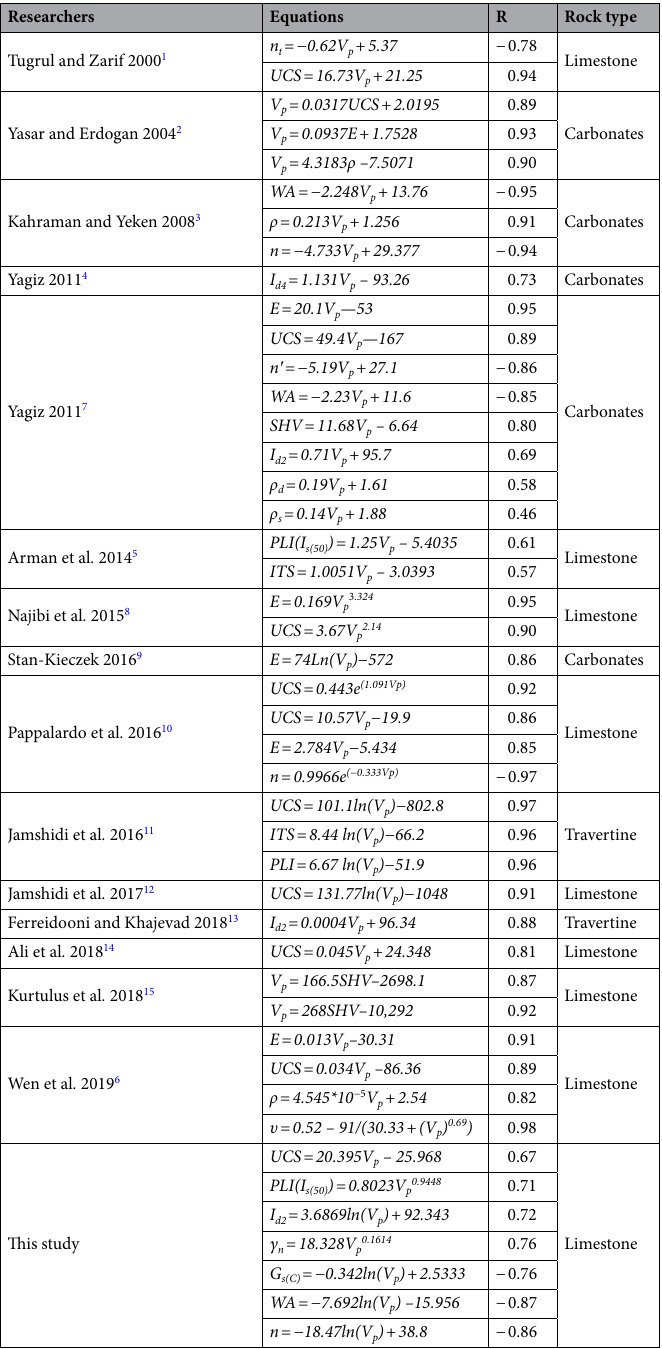
Table 1. Data of the correlation between some mechanical and physical properties of either carbonate rocks or limestone from published literature and this study. E: Modulus of Elasticity (GPa), UCS: Uniaxial